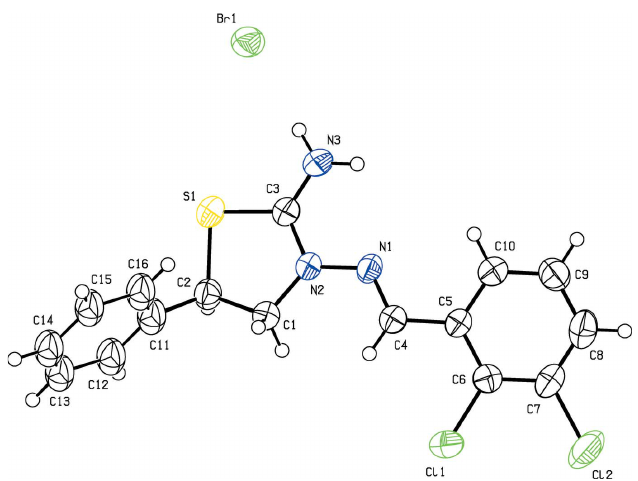
Figure 1 The molecular structure of the title salt. Displacement ellipsoids are drawn at the 50% probability level. Hydrogen atoms are shown as spheres of arbitrary radius. The minor disorder component is omitted for clarity. 222.1 (12) (cid:4) . The dihedral angle between the mean plane of the central thiazolidine ring and the 2,3-dichlorobenzene ring (C5–C10) is 16.0 (2) (cid:4) while this plane subtends angles of 79.1 (3) and 86.7 (4) (cid:4) with the major and minor components (C11–C16 and C11/C12 0 –C16 0 ), respectively, of the disordered phenyl ring. The dihedral angle between the two disorder components of the ring is 7.6 (4) (cid:4) and these components are